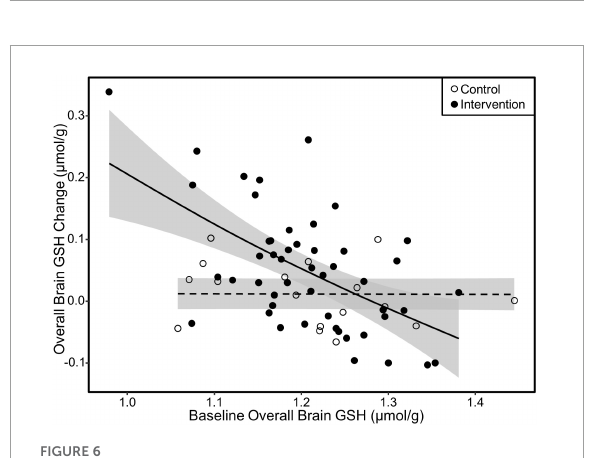
FIGURE6 Scatterplot of change in overall GSH as a function of baseline overall GSH concentration. The fit lines represent regression estimated means for the milk intervention (solid line) and control (dashed line) groups. Response to the milk intervention was highest in those with lower baseline GSH concentrations with attenuating response as baseline GSH approached 1.4 µ mol/g. There was no difference in GSH change due to baseline GSH in the control group. Similar relationships were also observed in the parietal and fronto-parietal regions. Shaded areas are 95% confidence